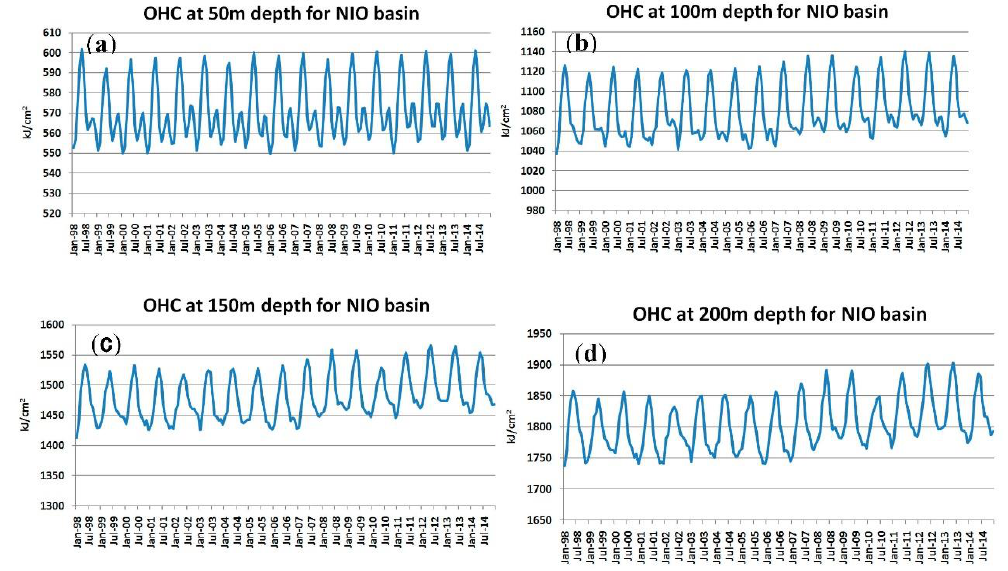
Figure 3. Time series of the North Indian Ocean (NIO) ocean heat content(OHC) from 1998 to 2014 for surface to ( a ) 50 m, ( b ) 100 m, ( c ) 150 m, and ( d ) 200 m